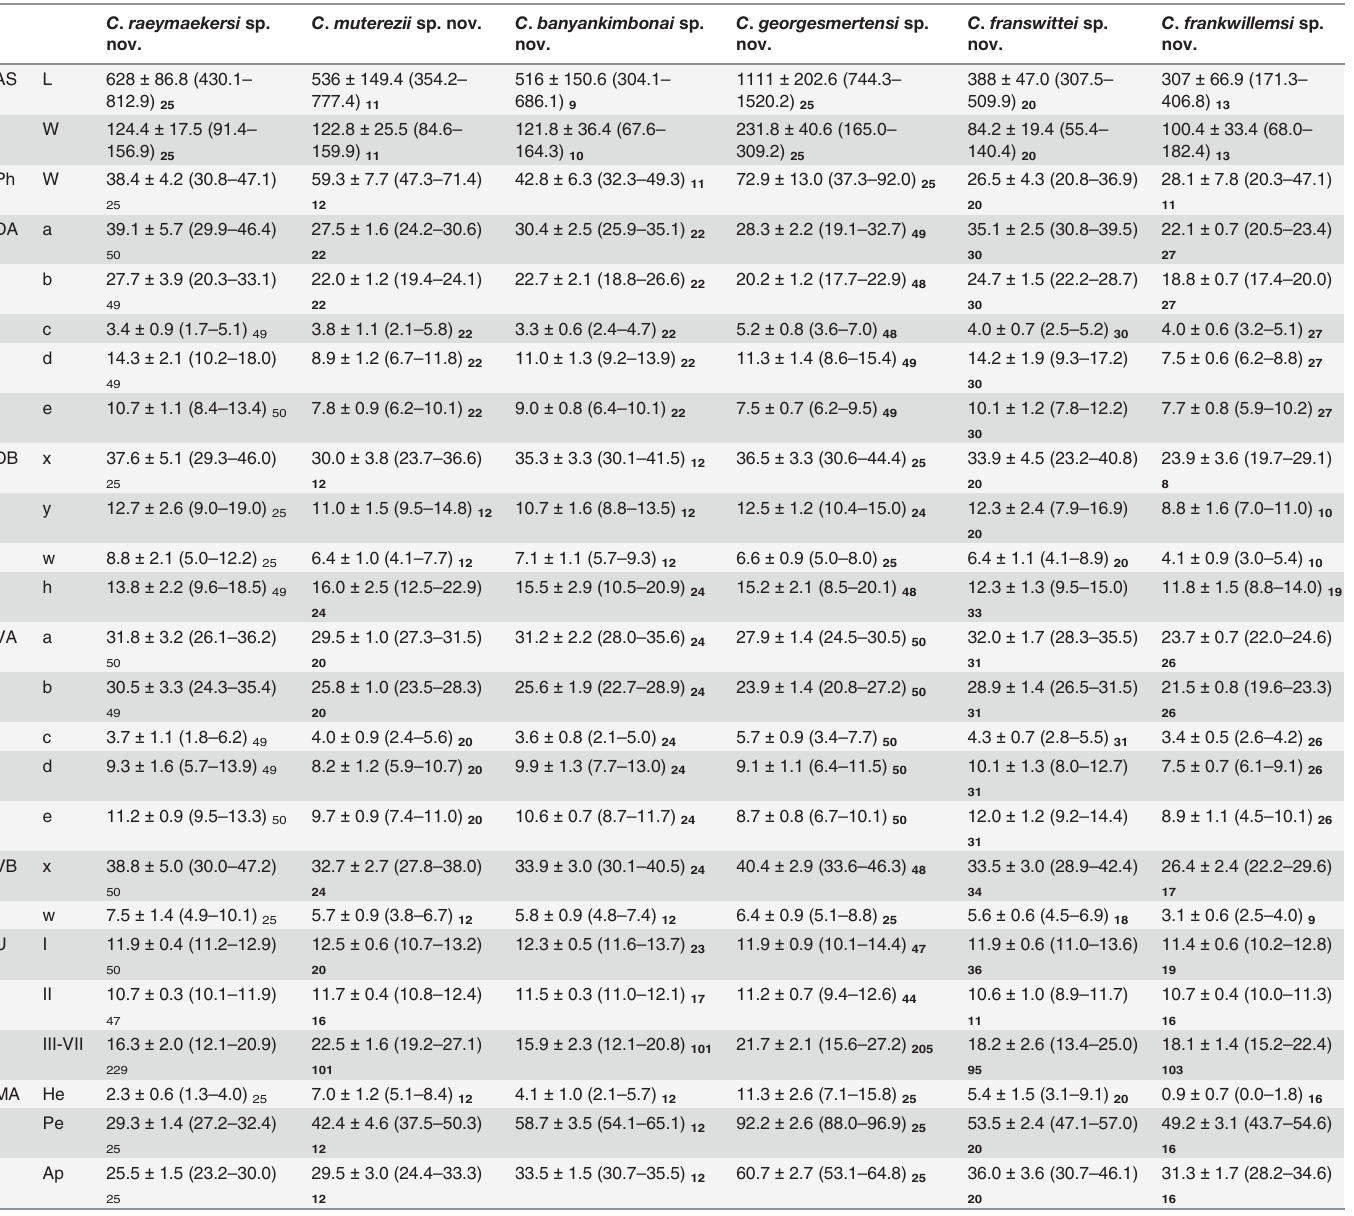
Table 9. Measurements of Cichlidogyrus species infecting Simochromis and Pseudosimochromis